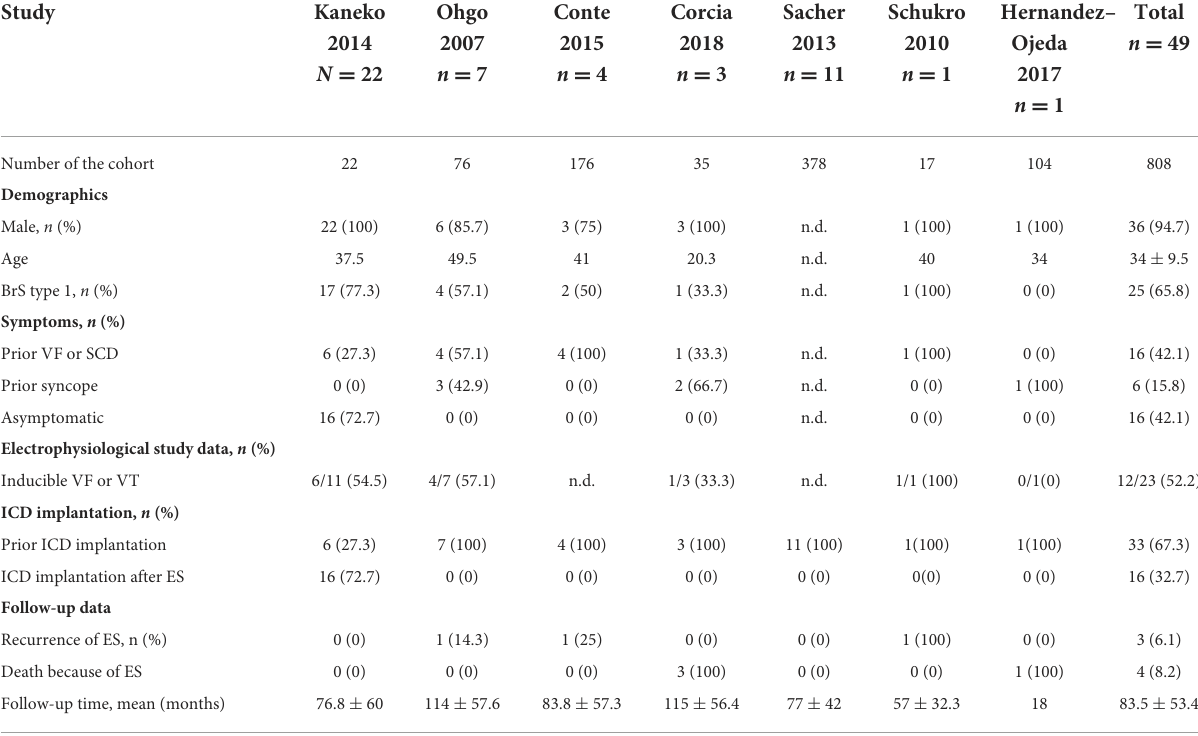
TABLE 1 Overview of baseline characteristics of BrS patients receiving ICD implantation and suffering from